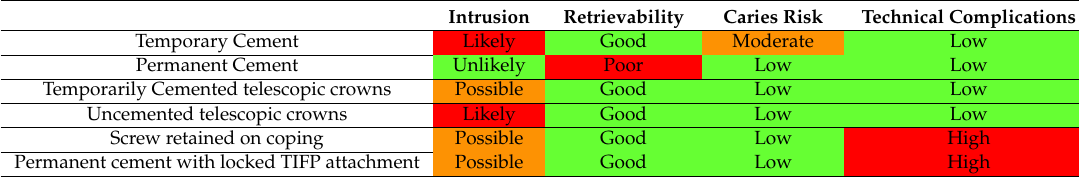
Table 7. Advantages and disadvantages of methods to secure a TIFP to a natural